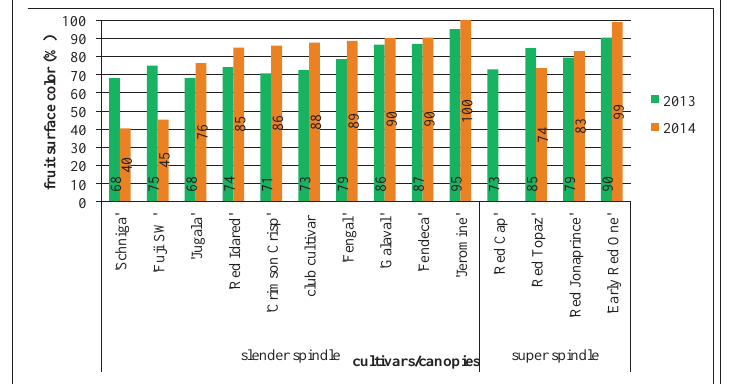
Figure 5: Fruit surface color of the cultivars (Nyírbátor, 2013 and 2014)